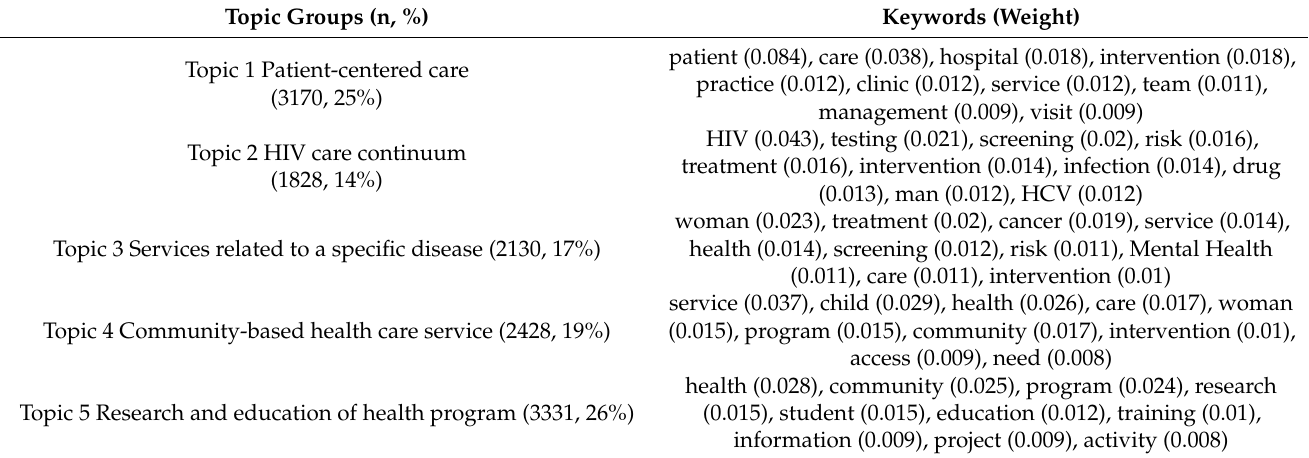
Table 4. Topic modeling of outreach